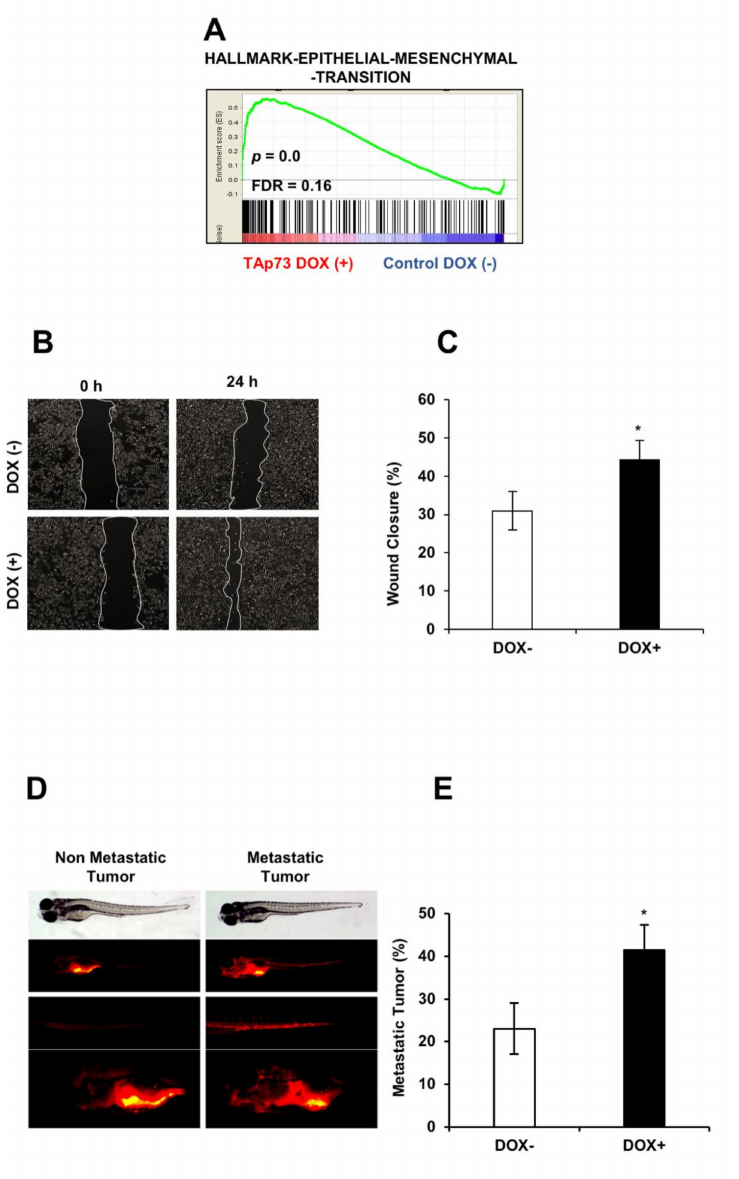
Figure 7. TAp73 β upregulates epithelial-mesenchymal transition hallmark genes and stimulates metastatic abilities of hepatocellular carcinoma cells. ( A ) Genes involved in epithelial-mesenchymal transition in TAp73 β induced cells. ( B ) Wound-healing assay was performed to examine the migration rate of Hep3B cells under TAp73 β induction. Images were captured at 0 and 24 h following the initial scratch. ( C ) Migration rates were quantified by measuring three different wound areas using ImageJ software, columns and error bars indicate mean ± SD from triplicate experiments. The graph is representative of three independent experiments. ( D ) This figure illustrates metastatic (right panel) and non-metastatic (left panel) tumors after 4 days grown in zebrafish larvae. Bright field picture of larvae was shown in the top level the bottom level pictures are fluorescent images of tumors in same animals. Fluorescent pictures in the middle shows metastatic tumor cells disseminated into tail region (right) as opposed to non-metastatic tumor cells (left). Hep3BTAp73 β cells were treated with doxycycline 1 µ g/mL for 72 h, stained with Dil and inoculated into the 2 dpf zebrafish embryos. Bright-field and fluorescent images of zebrafish were captured for non-metastatic and metastatic tumors. The number of embryos with metastasis was counted at day 4 dpi (days post-injection) ( E ). Three separate experiments were performed. Error bars, ± SD (number of zebrafish embryo, n = 30). * p <